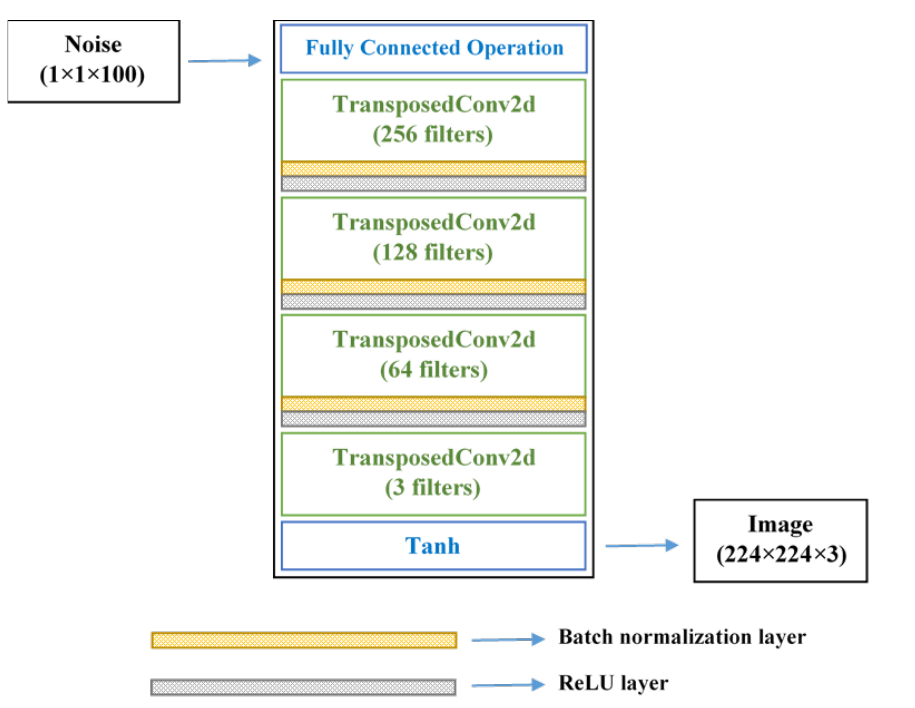
Figure 2. Network architecture of GAN-generator model.